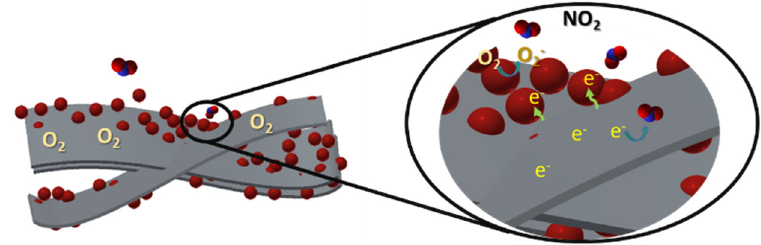
Figure 7. Schematic NO 2 -sensing reaction mechanism of ZnO/Ti 3 C 2 T x